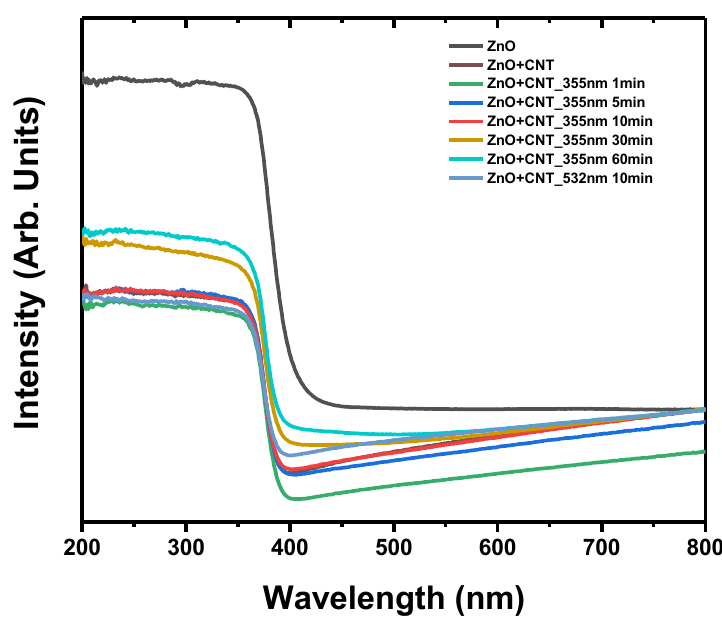
Figure 9. UV–vis absorption spectra of ZnO NS and ZnO NS-CNT hybrids. Figure 9. UV – vis absorption spectra of ZnO NS and ZnO NS-CNT hybrids.